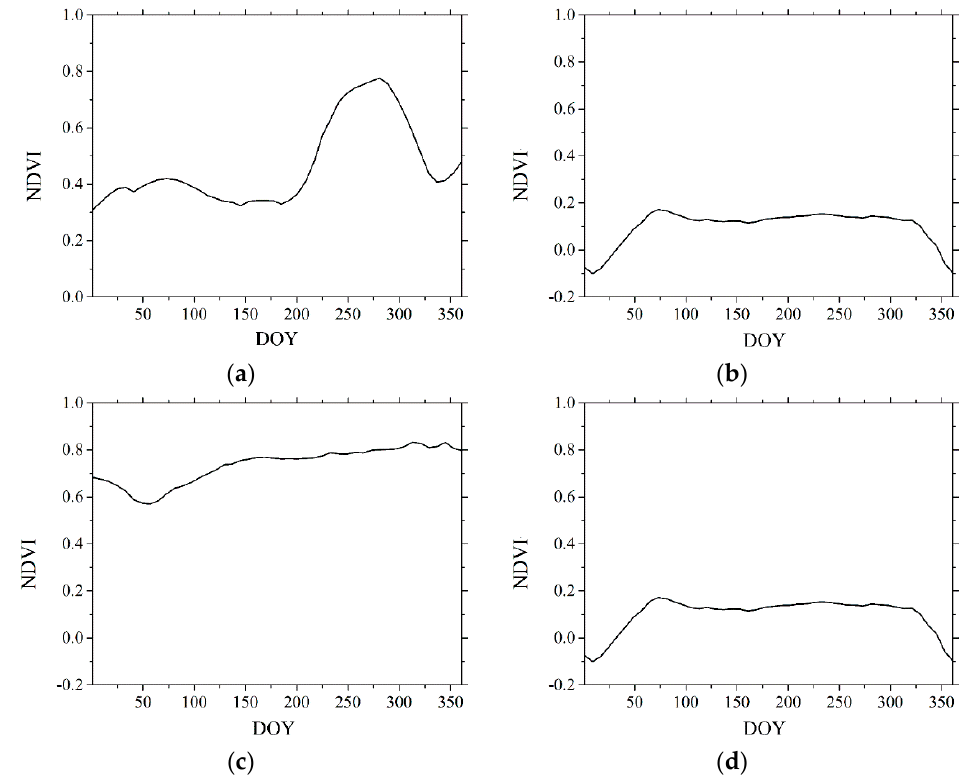
Figure 5. Normalized Difference Vegetation Index (NDVI) curves selected by Sample 2, which is a pure-pixel site. The reference NDVI time series is succinctly displayed with only four classes: ( a ) is the paddy rice annual NDVI curve; ( b ) water annual NDVI curve; ( c ) is the deciduous forest annual NDVI curve; and ( d ) is the evergreen forest annual NDVI curve.